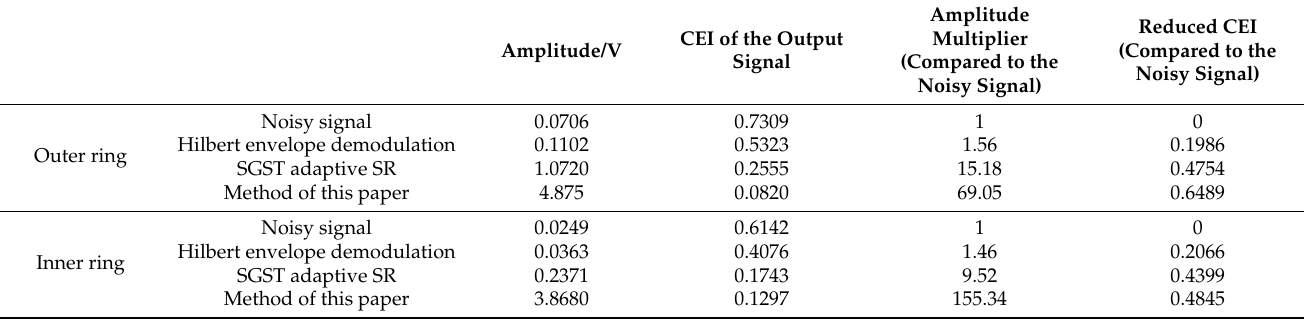
Table 4. The results of the three methods for fault signals.